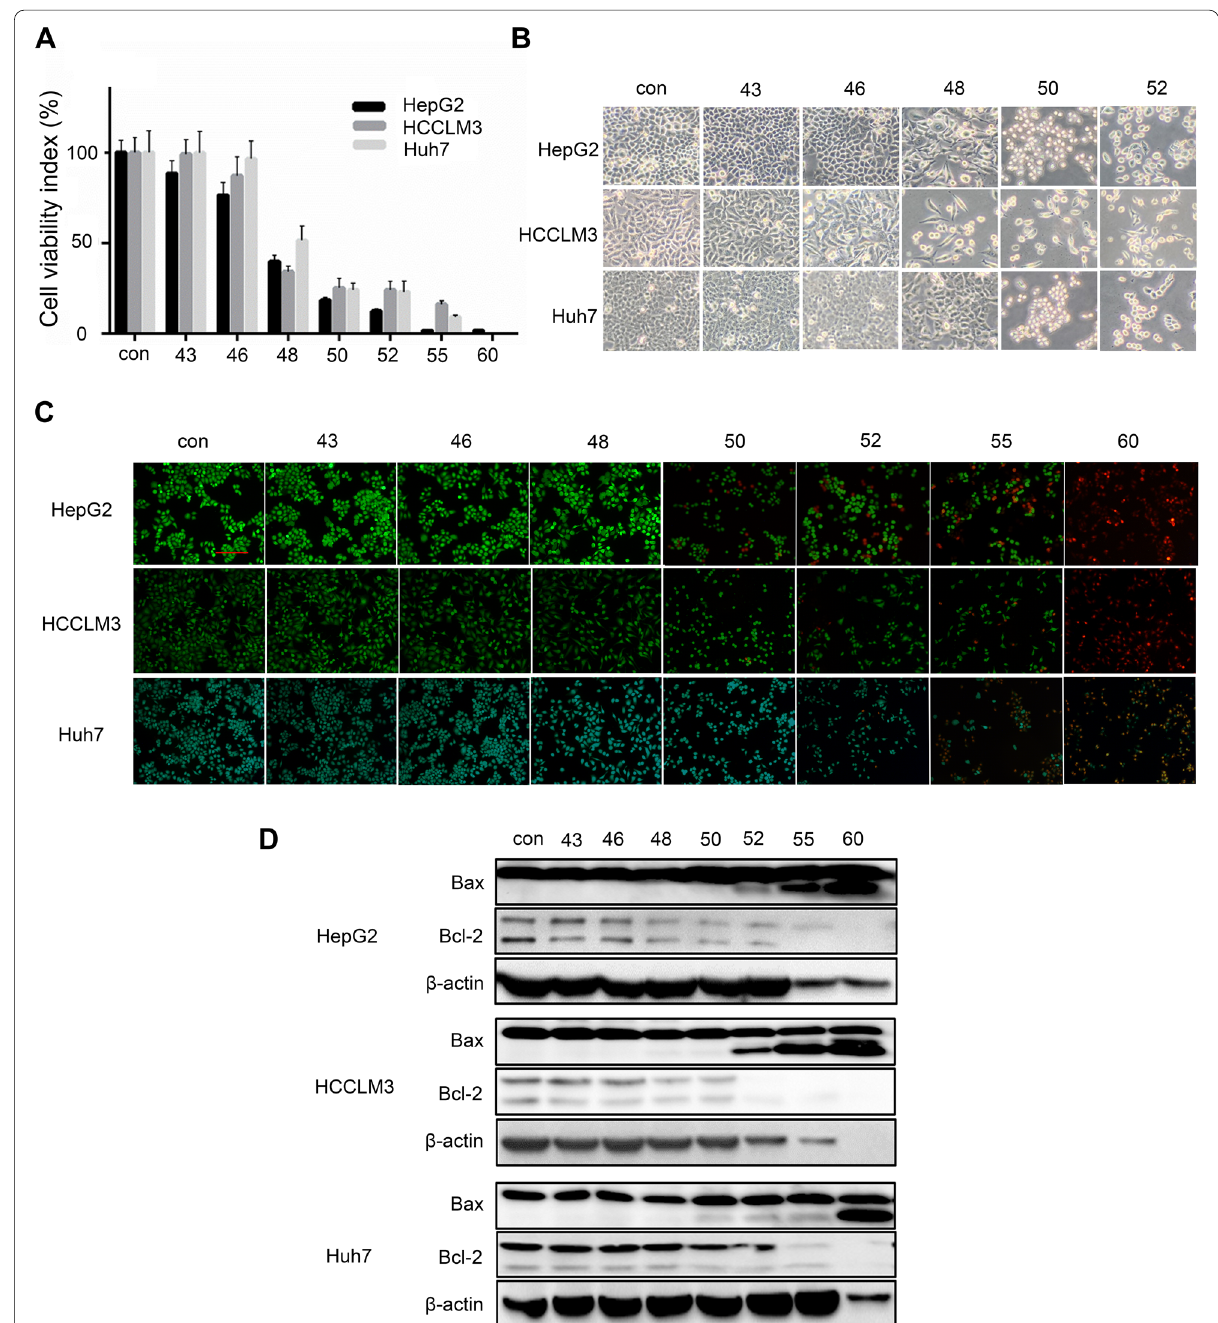
Fig. 5 Hyperthermia inhibits proliferation and induces apoptosis in HCC cells in vitro. A Cell viability of HepG2, HCCLM3 and Huh7 cells analyzed by MTT assays with increasing gradients of hyperthermia (43–60 °C). B Representative cell morphology images of HepG2, HCCLM3 and Huh7 cells with hyperthermia treatment. C Representative images of Calcein AM and PI costained cells by fluorescence microscope. D The expression of Bax and Bcl-2 explored by western blotting with β-actin used as a control. Data are presented as the mean